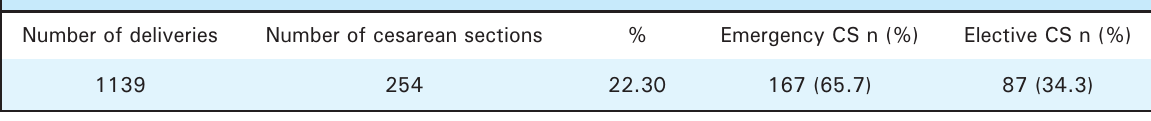
Table 1. Incidence of cesarean section in NMCTH.